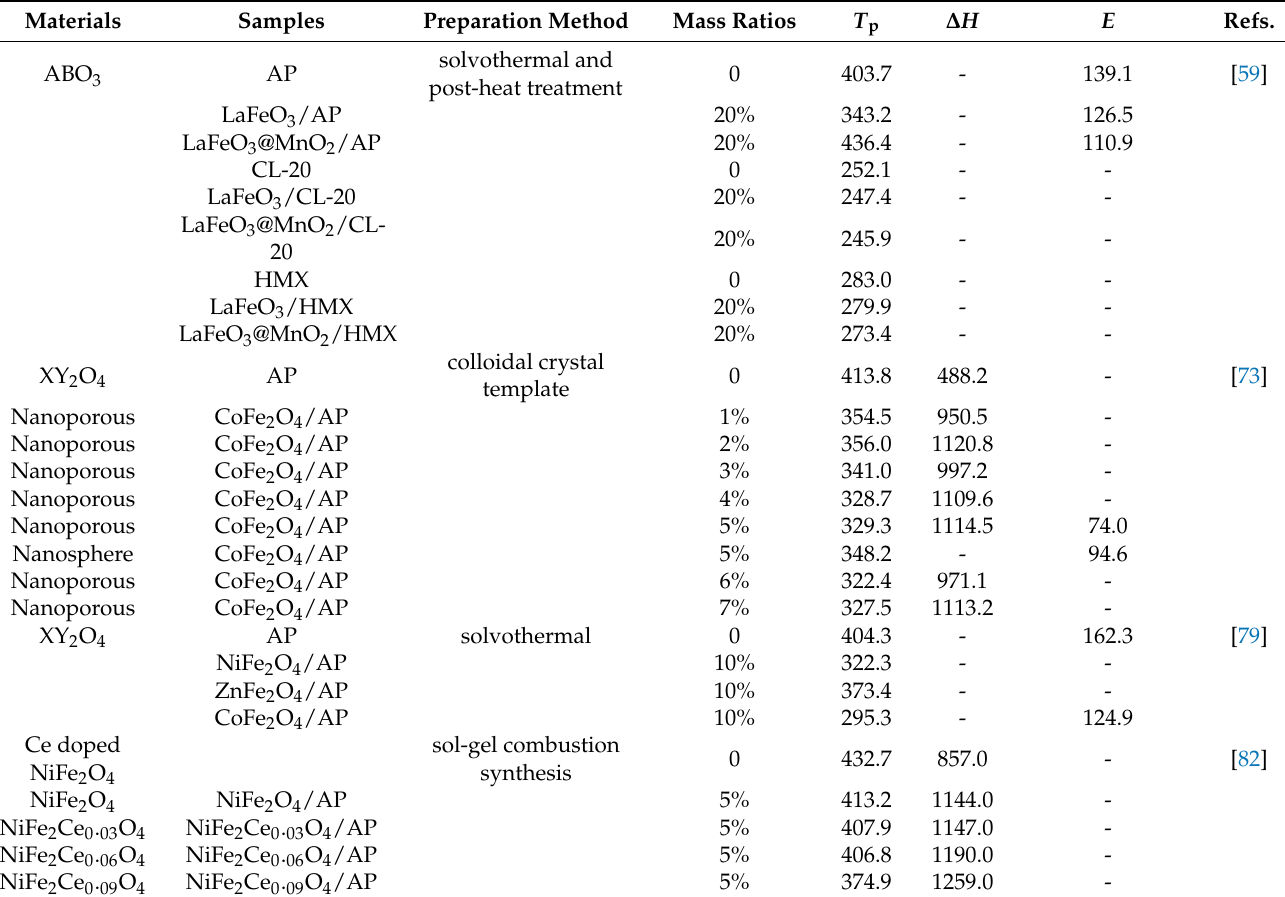
Figure 15. TEM images of the samples ( a ); DSC curves of different samples ( b ). Reproduced with the permission of ref. [81]. Copyright 2012, Journal of Solid Rocket Technology. Table 2. Summary of thermal behavior parameters of different ferrite EMs